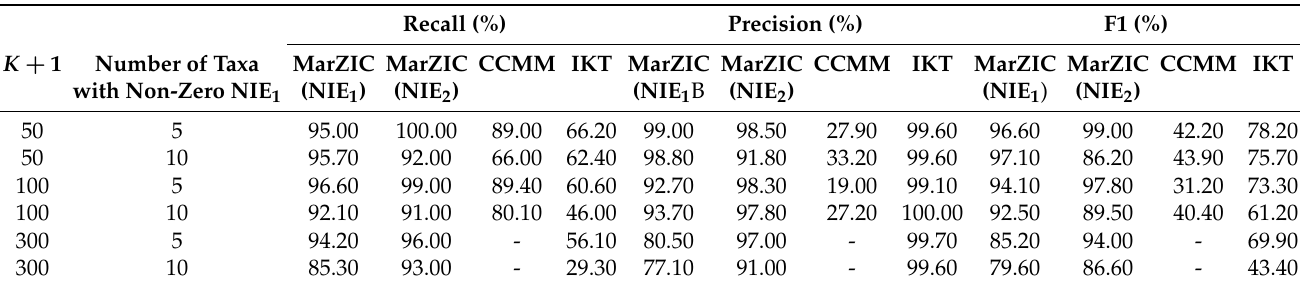
Table 3. Simulation results for the comparison of MarZIC with CCMM and IKT. Recall (%) F1